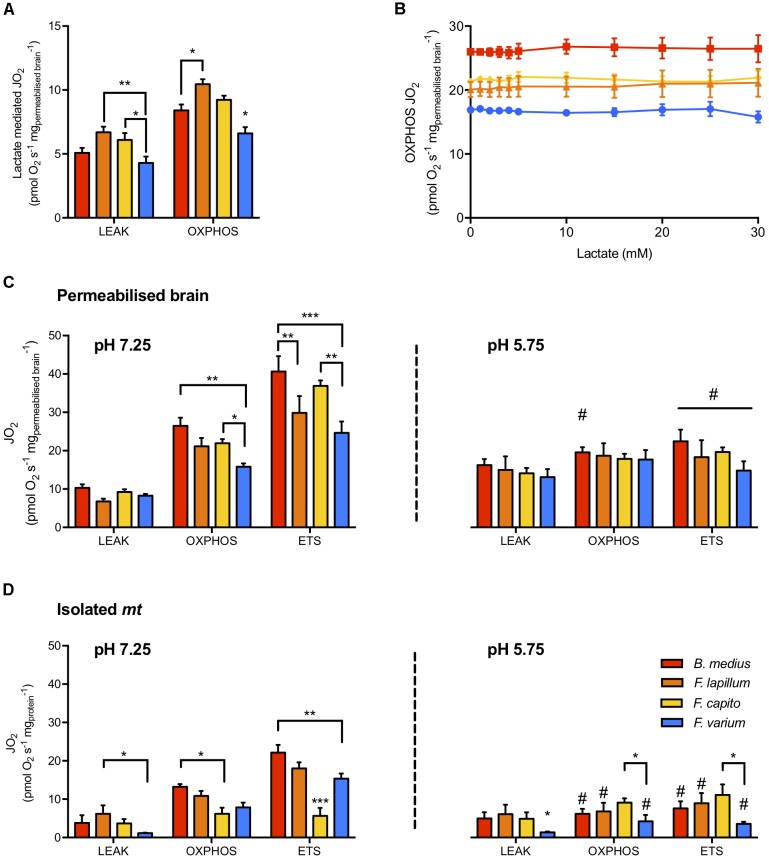
Mitochondrial respiration rates and the effect of lactate and pH on mitochondrial states. (A) The capacity of lactate (30 mM) to fuel LEAK and OXPHOS respiration in the absence of other mitochondrial substrates. (B) Titration of buffered lactate (pH 7.25) on mitochondria in OXPHOS state, in the presence of saturating CI and CII substrates (pyruvate, malate, glutamate and succinate), ADP and NAD+. In permeabilized brain (C) and isolated mitochondria (D), the respiration attributed to OXPHOS was determined with 30 mM buffered lactate. The portion of respiration attributed to proton leak (LEAK) was measured with the further addition of oligomycin and the maximum capacity of the electron transport system (ETS) was measured as the maximum respiration uncoupled from OXPHOS, reached with the titration of the uncoupler CCCP. Experiments were conducted at physiological pH (left panel) and acidic conditions (pH 5.75, right panel) mediated with 30 mM lactic acid instead of buffered lactate. Hypoxia tolerant species are presented in warm colors while the hypoxia sensitive species is presented in blue. Results presented as mean ± SEM of n = 7 individuals in (A,C) and n = 5 in (B). Significance difference between species at P < 0.05; 0.01 or 0.001 indicated as ∗, ∗∗, ∗∗∗, respectively, and between pHs (within a mitochondrial state) chosen at P < 0.05 and indicated as # (two-way ANOVA and post hoc test with Turkey correction).